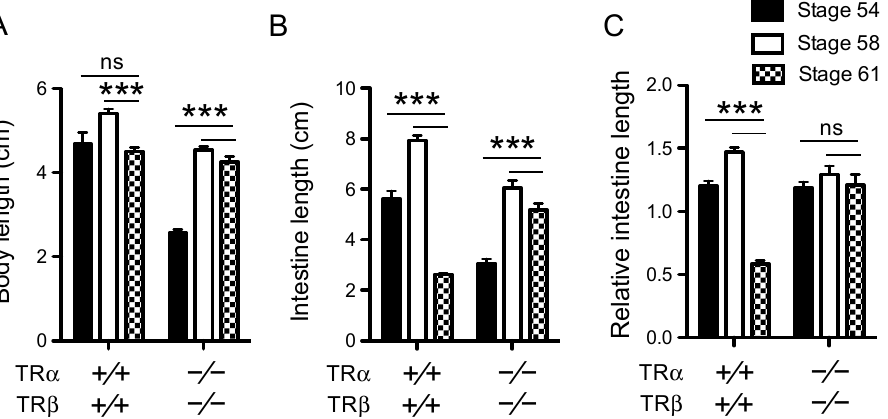
Figure 1. TR double knockout inhibits natural intestine shortening at the climax of metamorphosis. The total body length ( A ) and the intestine length ( B ) were measured for wild-type and TRDKO tadpoles at the indicated stages. The relative intestine length ( C ) was obtained by normalizing the intestine length against the total body length at the indicated stages. At least 4 tadpoles were analyzed for each sample. Asterisks (***) indicate a significant difference vs. stage 58 for the 2 genotypes ( p < 0.001, Bonfferoni comparison test). ns: No significant difference.